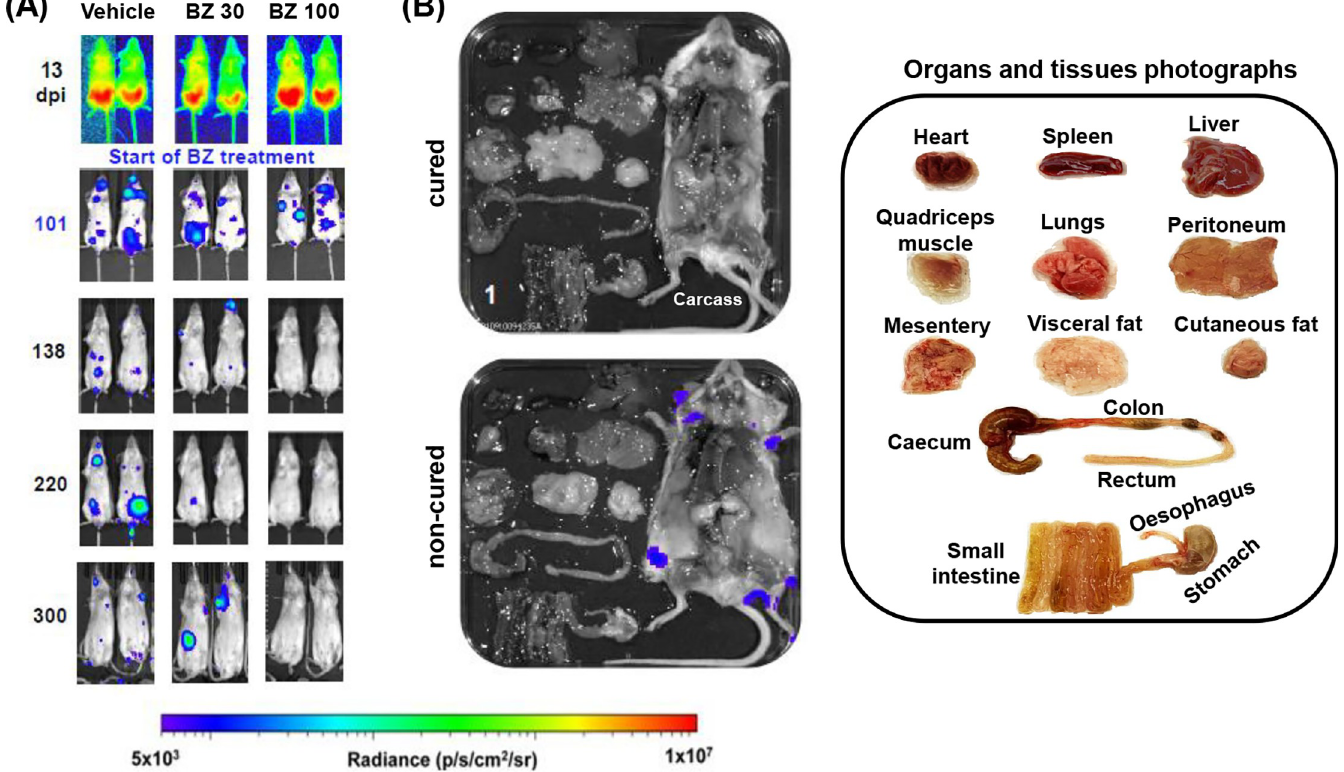
Fig 4. In vivo and ex vivo bioluminescence imaging of benznidazole-treated Trypanosoma cruzi infected mice. BALB/c mice were infected with bioluminescent T . cruzi (CL Brener strain) (Methods). 101 days post-infection (dpi), they were treated with benznidazole (BZ) at 30 or 100 mg kg -1 , once daily for 5 days by the oral route (n = 15 per group). In parallel, a control cohort was administered with the HPMC vehicle (Methods). The mice were monitored regularly by bioluminescence imaging. (A) Representative ventral images of two mice per group (see also S1 Fig). (B) At the experimental end-point, mice were euthanized and organs and tissues were arrayed in a square petri dish, bathed in d-luciferin, and subjected to ex vivo imaging (Methods). The organs and tissues are organized as shown in the inset (right). See S2 Fig for other examples. All images use the same log10 scale heat-map with minimum and maximum radiance values as indicated. Mice that were bioluminescence negative at the experimental end-point by both in vivo and ex vivo imaging were designated as